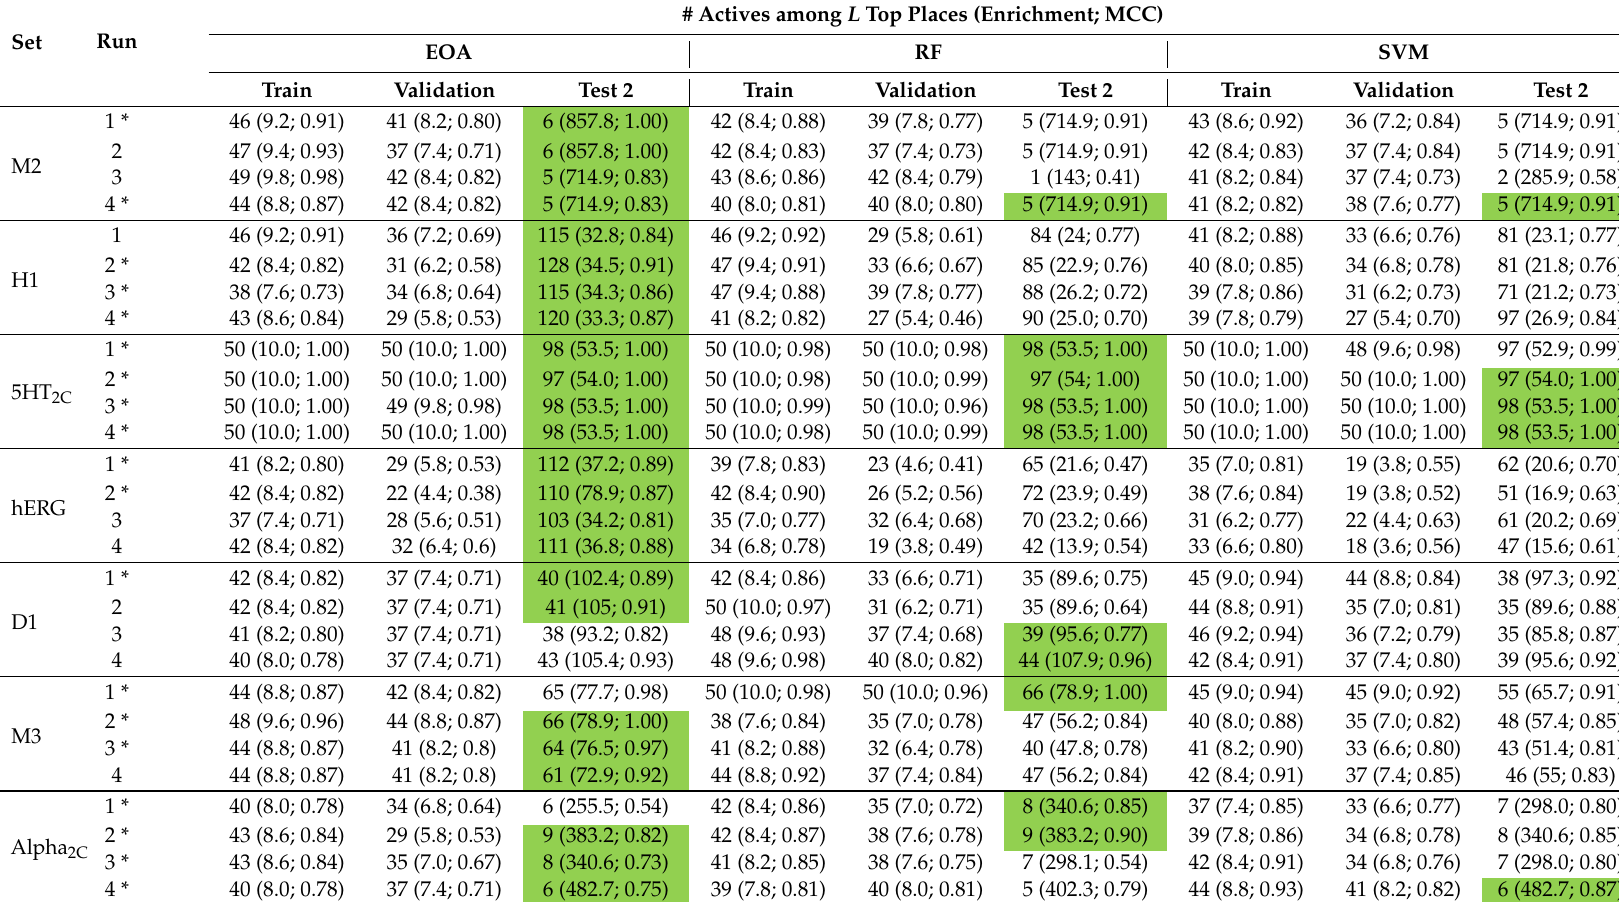
Table 4. The same as Table 3 but the best Enrichment Optimizer Algorithm (EOA) models were selected based on their performances on test set 2. Asterisks (*) denote cases where the same model performed best for both test set 1 and test set